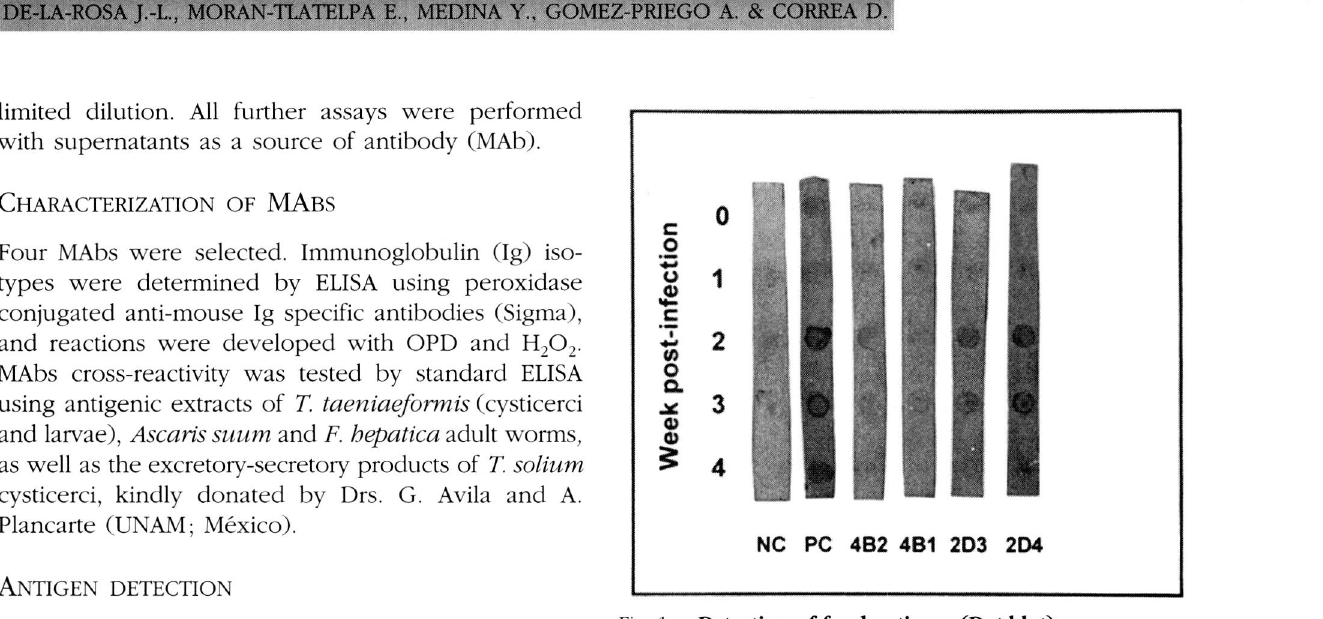
Fig. 1 . - Detection of fecal antigens (Dot-blot). Fecal supernatants were obtained at 0, 1, 2, 3 and 4 week post infec tion. Antigens were detected using four monoclonal antibodies (4B1, 4B2, 2D3 and 2D4). Reaction using non-immune mouse serum (NC) or hyperimmune mouse serum (PC) are also shown.